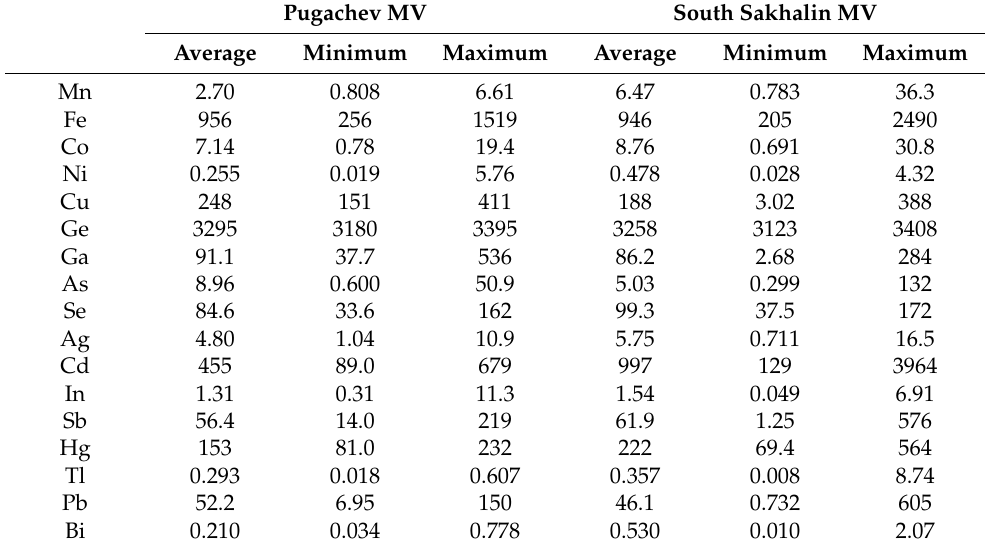
Table 7. Average trace-element compositions of low-Hg sphalerite with homogenous Hg distribution from mud masses of Pugachev (n = 13) and South Sakhalin (n = 22) MVs, Sakhalin Island. LA-ICP-MS data,